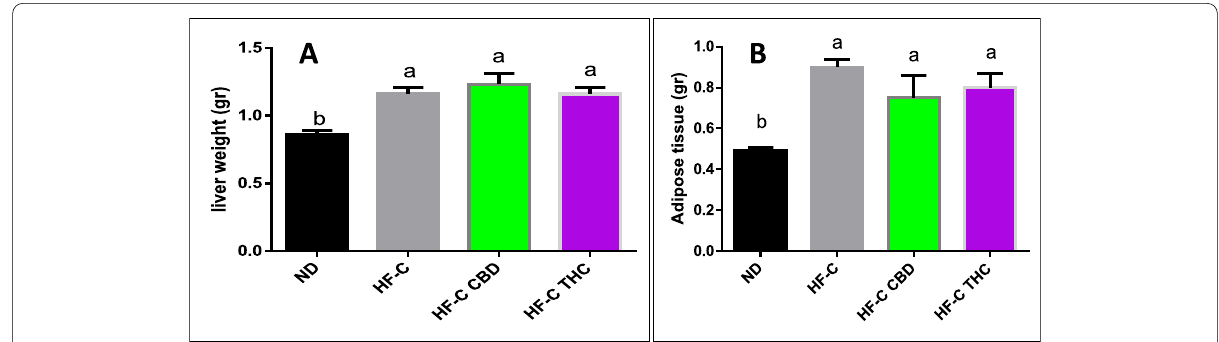
Fig. 3 Effect of THC or CBD treatment on liver and adipose tissue weight in mice fed HFCD. Male C57BL/6J mice aged 7–8 weeks were fed either normal diet (ND, n 8), high fat 1%(w/w) cholesterol 0.5%(w/w) cholate diet (HF‑C, n = + + n 8), HFCD containing THC (2.5 mg/kg) (HF‑C THC, n 8). Liver ( A ) or adipose ( B ) tissue weight of mice at the conclusion of the experiment is = = expressed as mean SEM. Columns marked with different letters (a, b) are significantly different ( p < 0.05) according to the Tukey–Kramer post hoc ± test